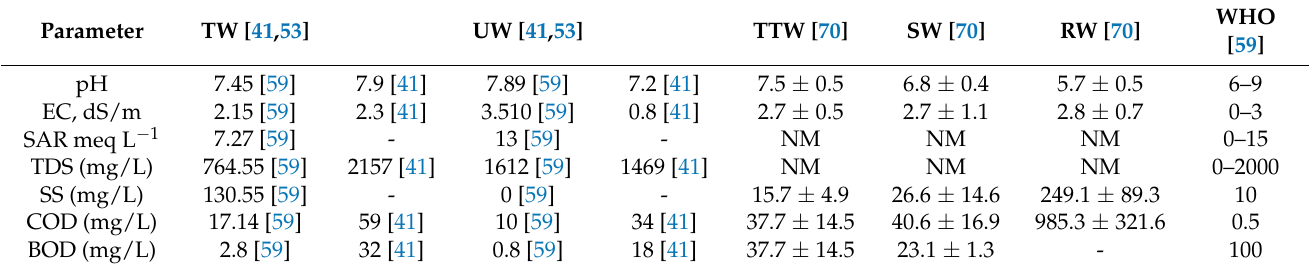
Table 2. Quality indicators of purified and potable wastewater used for irrigation (data from